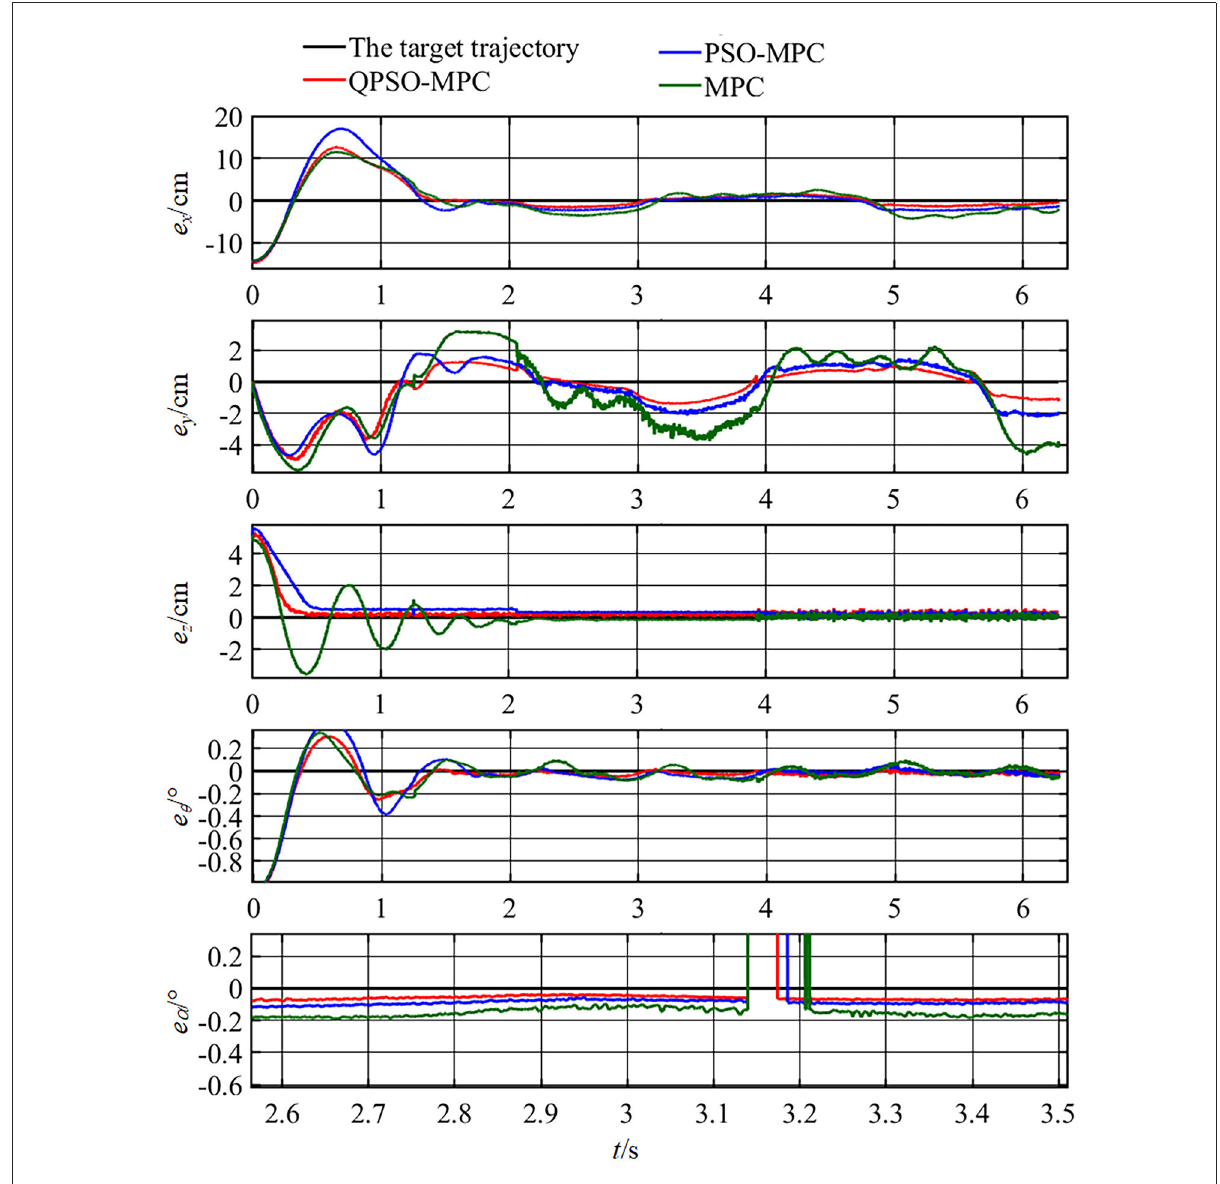
FIGURE13 Tracking errors of the spiral trajectory